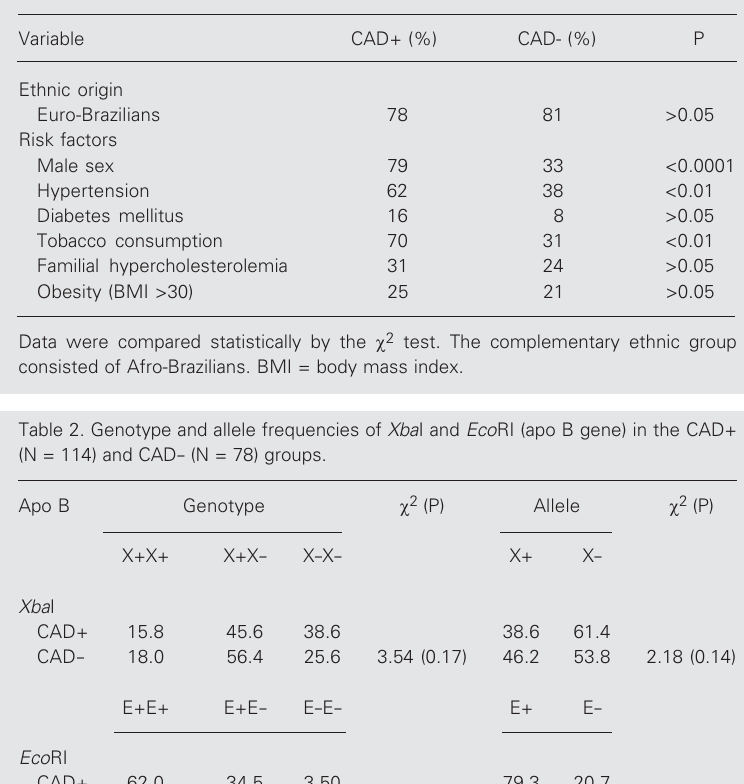
Table 1. Frequency distribution of ethnic origin and risk factors for coronary artery disease found in the CAD+ (N = 116) and CAD- (N = 78) groups.